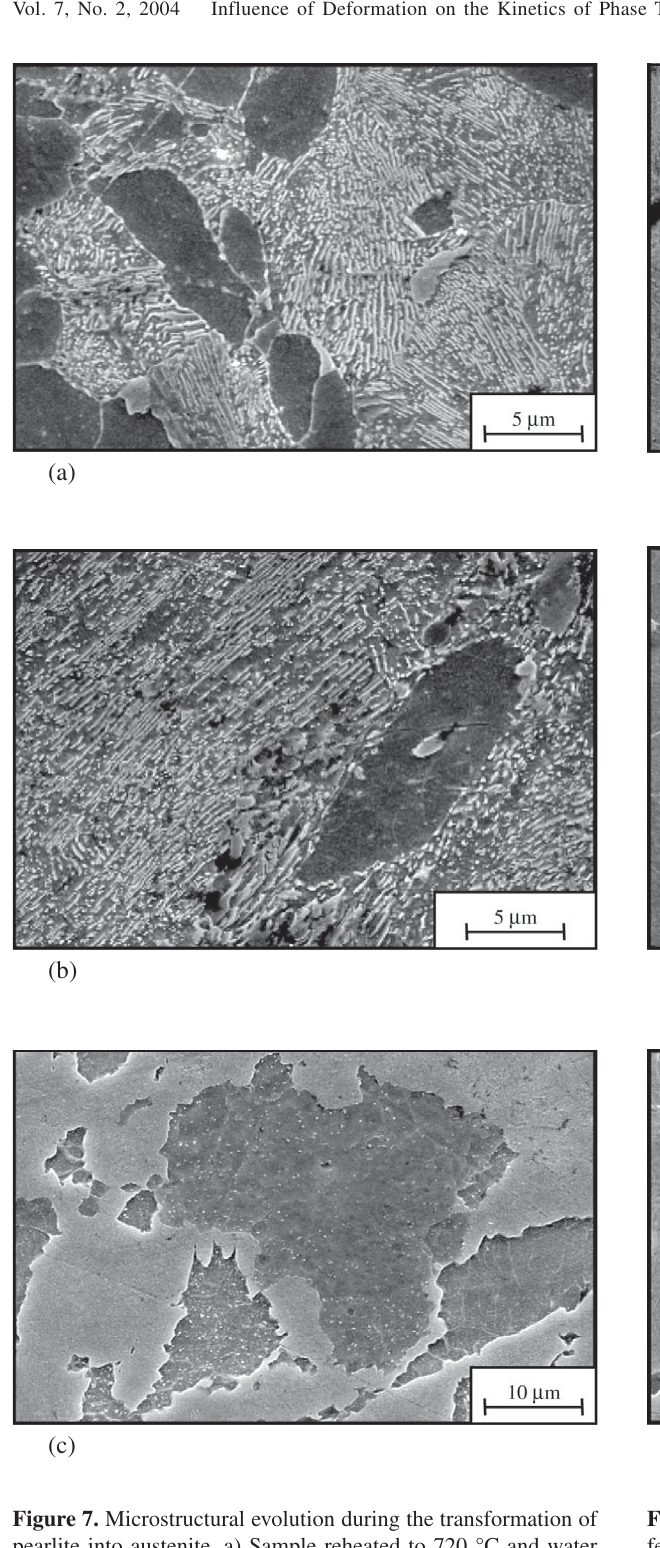
Figure 7. Microstructural evolution during the transformation of pearlite into austenite. a) Sample reheated to 720 °C and water quenched after 3 min holding time; b) Sample strained to ε = 1.5 at 720 °C after a 3 min holding time; c) Sample reheated to 750 °C and water quenched after 1 min holding time.